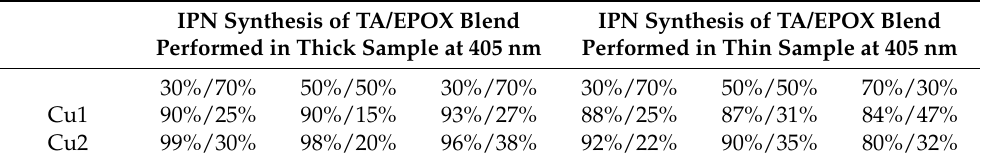
Table 4. Final conversions of acrylate and epoxides functions for the IPN synthesis of TA/EPOX blend using Cu1 (or Cu2)/Iod/NPG (0.1%/1%/1%/ w / w / w ) as PIS upon exposure to visible light at 405 nm.